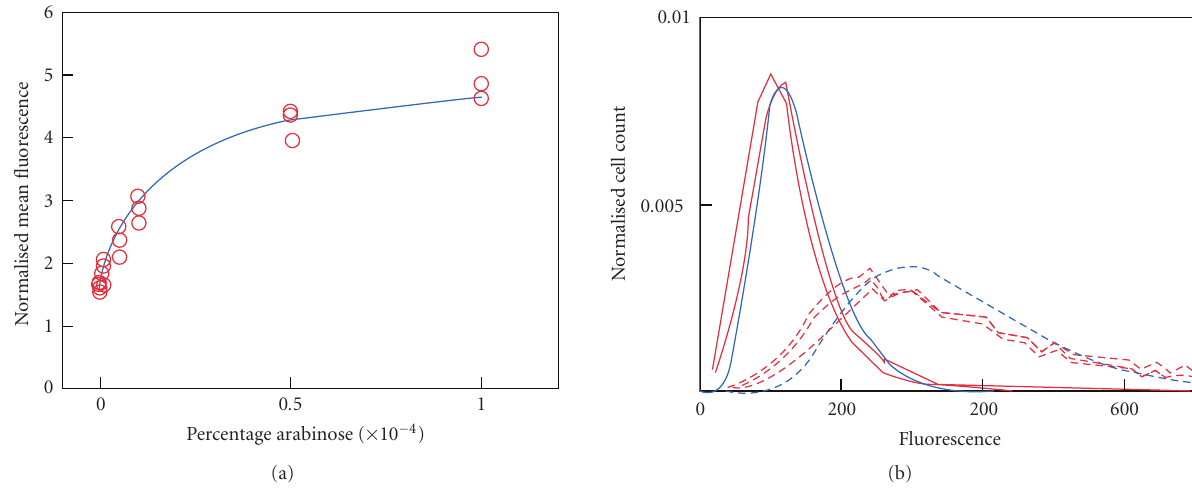
Figure 10: Model predictions and analysis of the repressor-activator system in Guido et al. [8]. (a) Simulations with baseline deterministic model: dependence of the model response (GFP fluorescence) of the repressor-activator system on arabinose concentration, with IPTG concentration maintained constant. The model simulation is shown with a blue line and experimental data points are shown with red circles. (b) Simulations with the extended stochastic model: distribution of GFP fluorescence within the cell population for levels of arabinose ranging from no arabinose (solid lines toward left) to the maximum possible level of arabinose (dashed lines toward right); IPTG concentration is maintained constant throughout. Stochastic model simulations are shown with blue lines and experimental data is shown with red lines (from Guido et al. [8], with